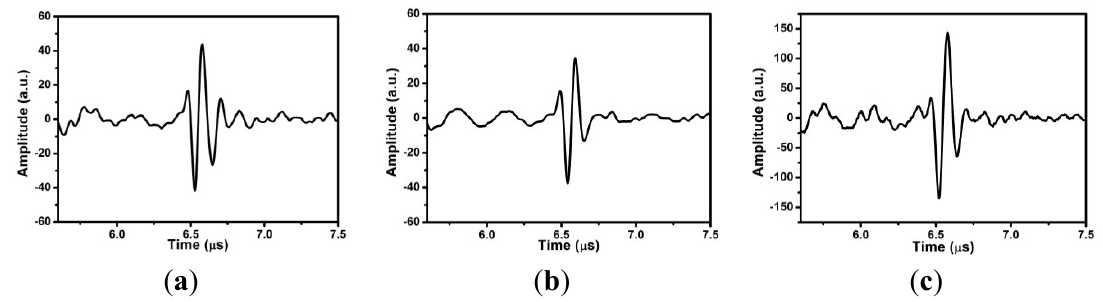
, ( b ) the pitch-catch signal A Figure 5. ( a ) The pulse-echo signal A 44 synthesized signal S of the target point (10 mm, 13.5 mm) for 8-elements FUT array 4 (element size: 10 mm × 2 mm, gap: 1 mm) inspecting an Al alloy block with a SDH of φ 3 mm at the middle at 150